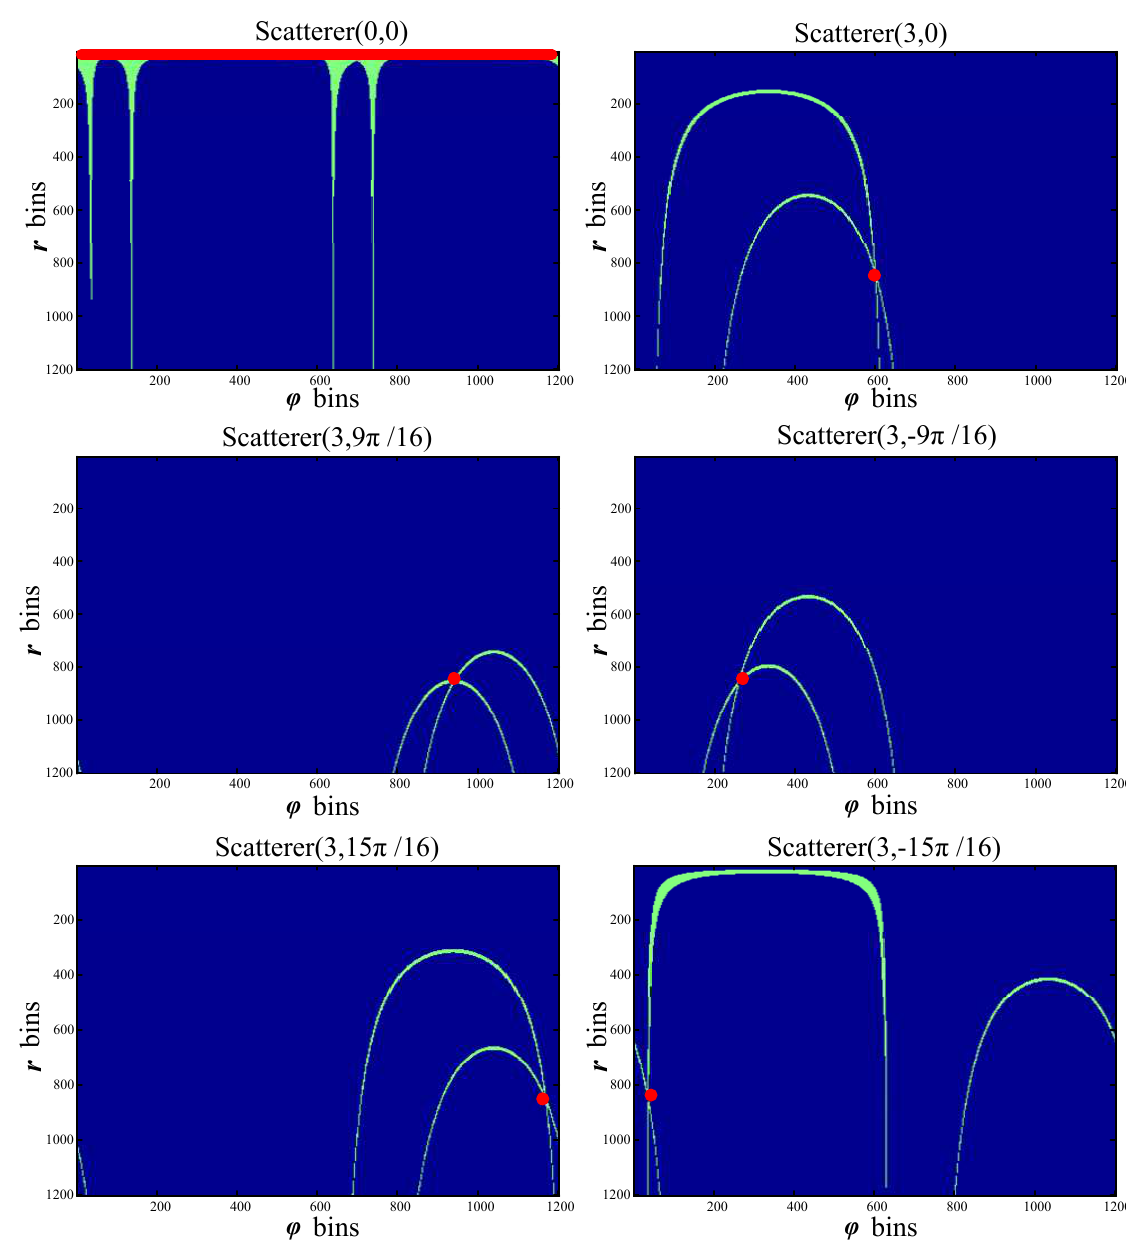
Figure 4. Position estimation of six scatterers using two frequency